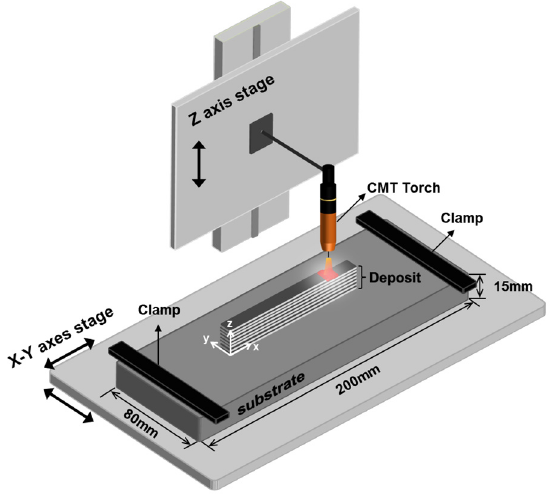
Figure 1. A schematic diagram of cold metal transfer (CMT) wire arc additive manufacturing (WAAM) equipment.